Question: Provide a one-line summary of what is displayed.
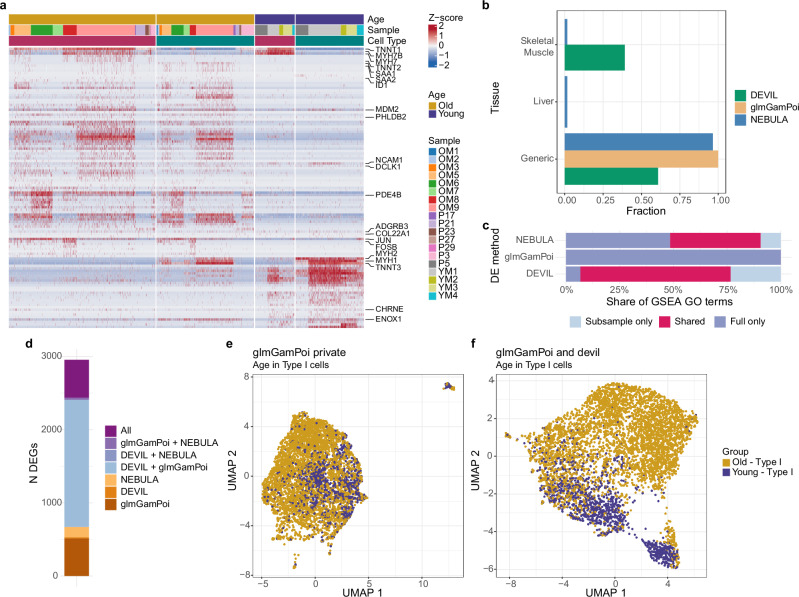
Answer: Robustness and specificity of aging-associated signals. a Heatmap of z-score–normalized expression for the top aging-associated differentially expressed genes identified by DEVIL, with cells annotated by age, sample, and myofiber subtype. b Fraction of enriched Gene Ontology biological process terms classified as skeletal muscle-specific, liver-related, or generic for aging in Type I myonuclei, across methods. c Overlap of enriched GO terms between full and subsampled datasets for aging in Type I myonuclei, showing terms detected only in the full dataset, only in subsampled data, or shared between the two. d Number of differentially expressed genes uniquely identified by each method or shared across methods for aging in Type I myonuclei. e , f UMAP embeddings constructed using top 100 DE genes identified exclusively by glmGamPoi ( e ) or shared between glmGamPoi and DEVIL ( f ), with cells colored by age group. Source data are provided as a Source Data file.